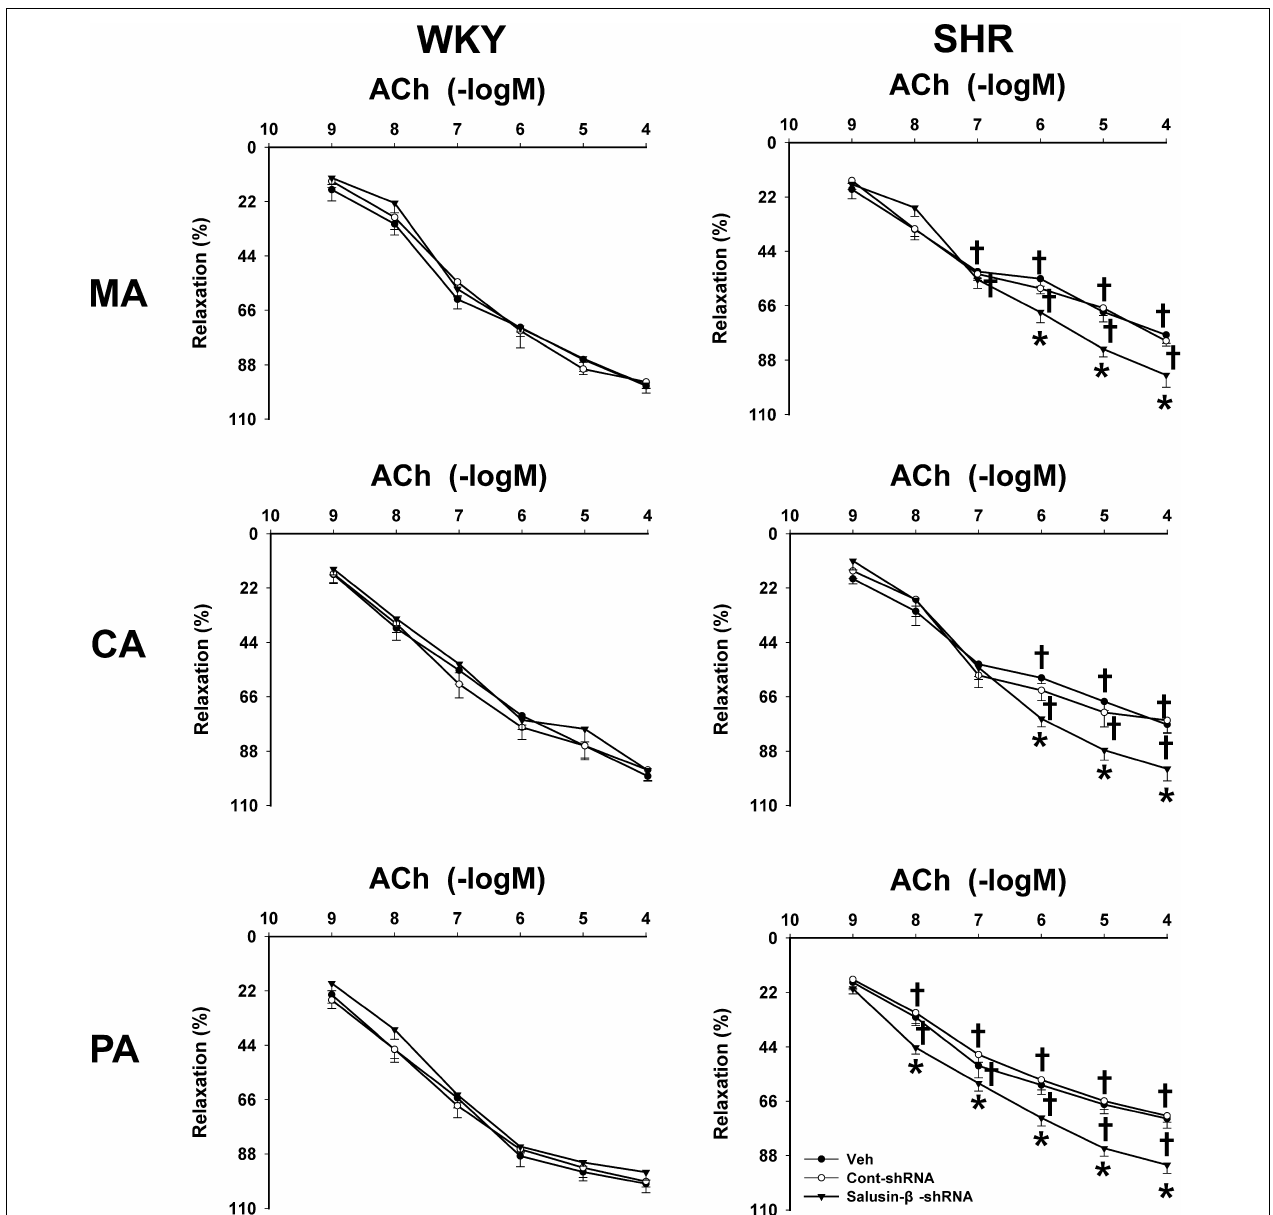
FIGURE 2 | The effects of salusin- β knockdown on ACh-induced dose-dependent relaxation in MA, CA, and PA in WKY and SHR. One-way ANOVA was used for data analysis in MA, CA, and PA of WKY rats, and two-way ANOVA was used for data analysis in SHR rats, followed by Bonferrioni post hoc test to compare with the multiple groups. Values are mean ± SE. ∗ P < 0.05 compared with Veh or Cont-shRNA, † P < 0.05 compared with WKY. n = 6 for each